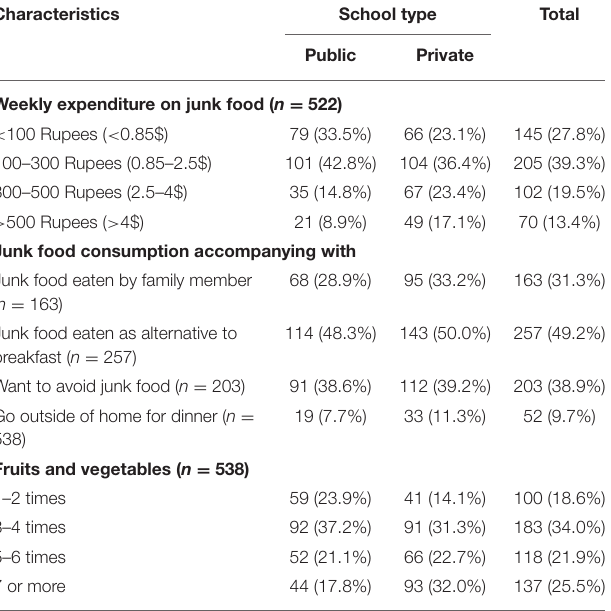
TABLE 5 | Distribution of weekly expenditure on junk foods, consumption accompanying fruits and vegetables among the participants.